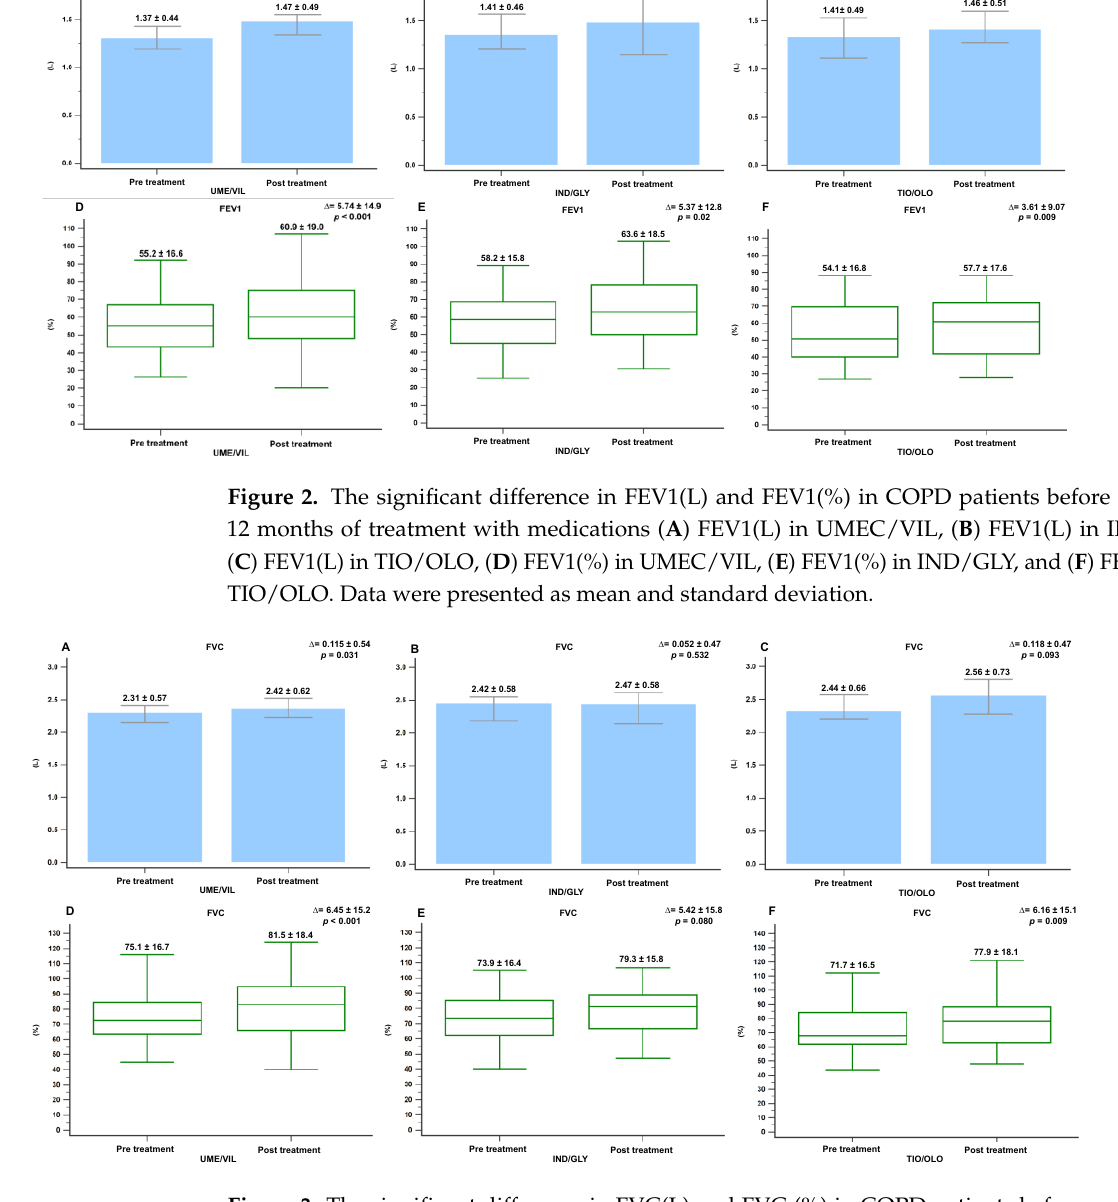
Figure 3. The significant difference in FVC(L) and FVC (%) in COPD patients before and after 12 months of treatment with medications ( A ) FVC(L) in UMEC/VIL, ( B ) FVC(L) in IND/GLY, ( C ) FVC(L) in TIO/OLO, ( D ) FVC(%) in UMEC/VIL, ( E ) FVC(%) in IND/GLY, and ( F ) FVC(%) in TIO/OLO. Data were presented as mean and standard deviation.